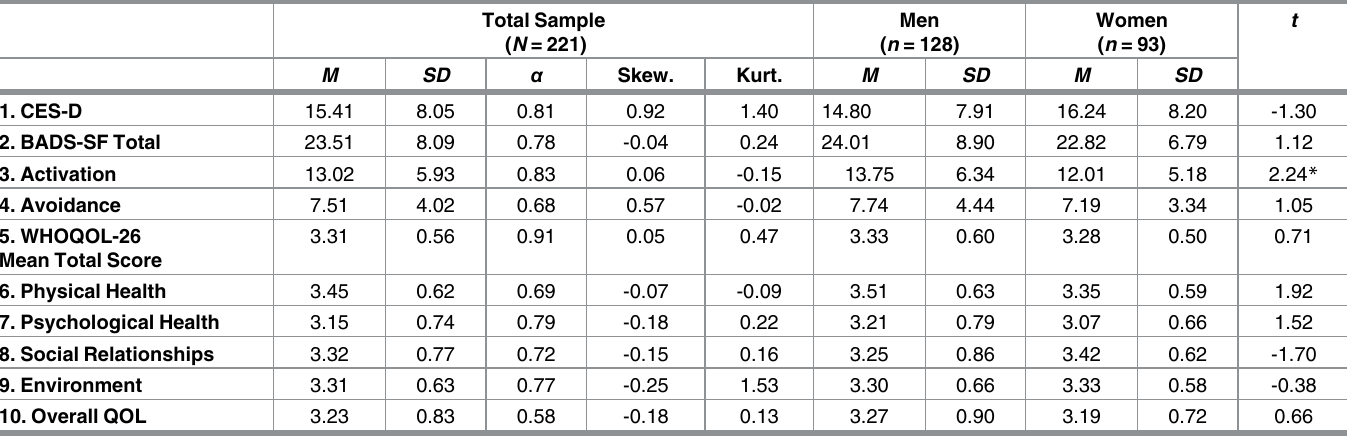
Table 1. Descriptivestatistics of participants’ scores by